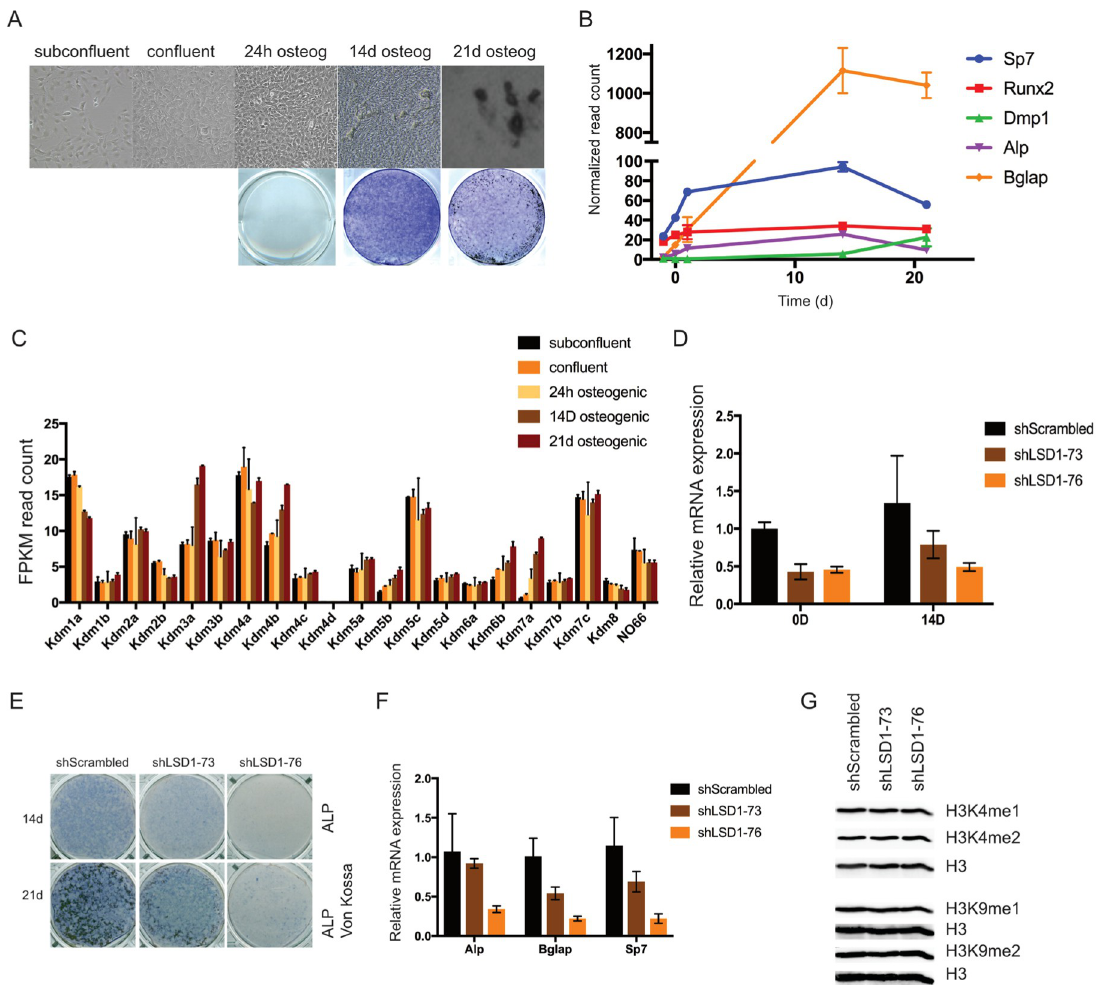
Fig 1. Lsd1 is abundantly expressed in osteoblasts and important for osteoblast differentiation. (A, B) RNA-seq analysis was performed from MC3T3-E1 at different stages of differentiation. The differentiation was verified by Von Kossa (top) and ALP staining (bottom) (A) and by expression profiles of osteoblast biomarkers in RNA-seq data (n = 2)(B). (C) mRNA expression of KDMs in MC3T3-E1 cells at different stages of differentiation measured by RNA-seq. Average of FPKM normalized read counts from two replicate samples for each time point are shown. (D) Knockdown of Lsd1 mRNA in MC3T3-E1 cells by stable shRNA expression shown by quantitative qPCR. B-actin normalized Lsd1 mRNA expression relative to shScrambled cells from three replicate samples is shown. (E) shLSD1 knockdown cell and control shScrambled were cultured in standard osteogenic conditions for 14 and 21d and fixed in 10% formalin. Differentiated phenotype was demonstrated by ALP and Von Kossa staining and by (F) quantitation of osteogenic genes mRNA expression at 14D differentiated cells by qPCR (n = 3). (G) Western blot showing Lsd1 protein and methylation state of histone H3 in shLSD1 knockdown cells. (E, F) Results from a representative cell culture experiment from three independent experiments is shown. P- values for statistically significant differences are marked � P < 0.05, �� P < 0.01, ��� P <